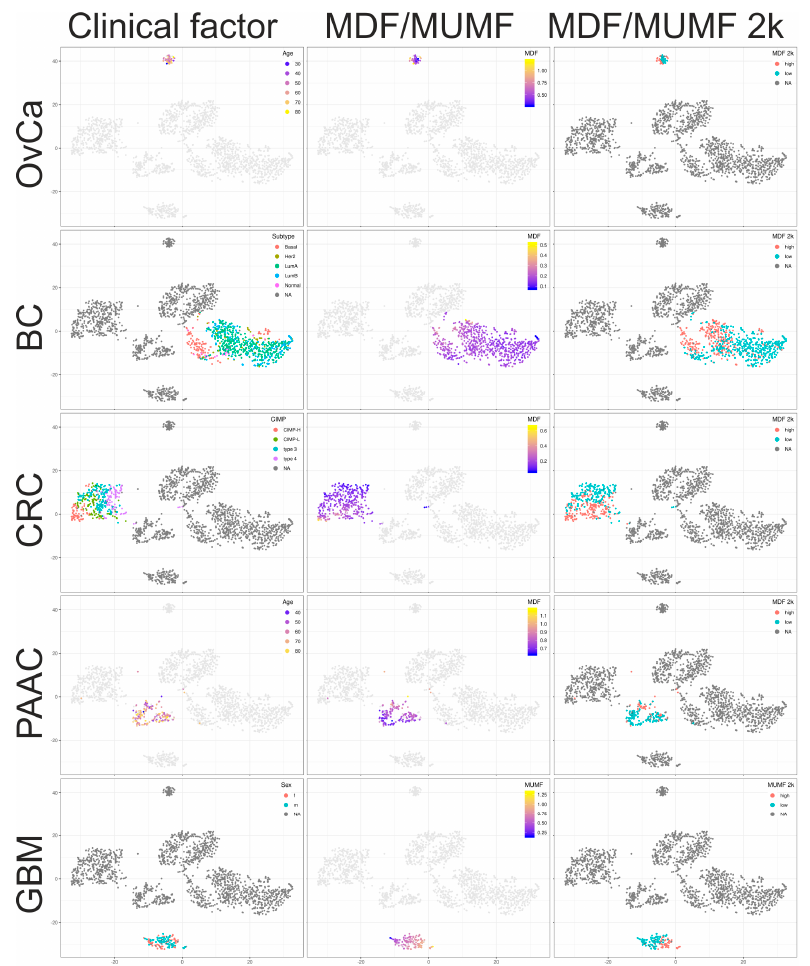
Figure 4. T-distributed stochastic neighbor embedding (tSNE) of the GB-averaged beta values as in Figure 3, colored according one relevant clinicopathologic factor (age for OvCa and PAAC, the subtype for BC, the CIMP status for CRC, and sex for GBM) in the left panel, colored by the MDF / MUMF values in the middle panel, and colored according the optimally dichotomized MDF / MUMF in the right panel.